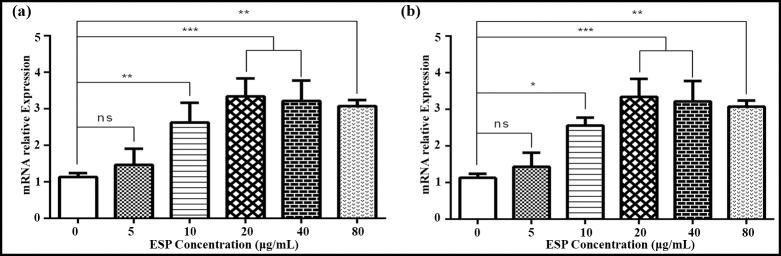
Relative expression of IL-9 cytokine in goat PBMCs stimulated by the ESPs in vitro.(a): IL-9 expression of trial 1; (b): IL-9 expression of trial 2. Cells were incubated with a serial concentration of ESP for 48 h, and a reverse-transcription-polymerase chain reaction quantified the mRNAs encoding interleukin-9 (IL-9). The significant level were set of two experiments at **p < 0.05, **p < 0.01, ***p < 0.001, and ns non-significant compared with the untreated group (control).Data are representative of three independent experiments.